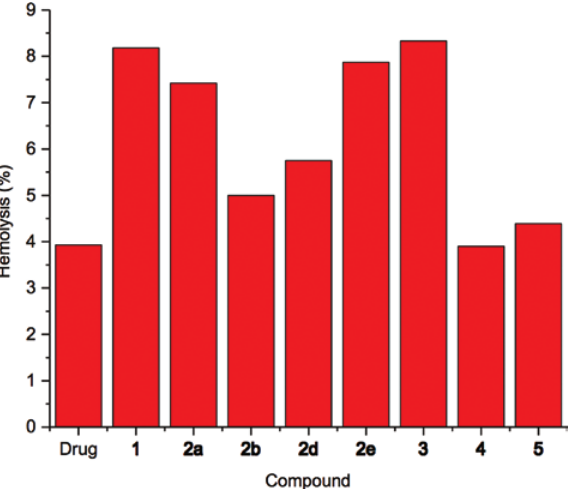
Figure 4: Anti-inflammatory